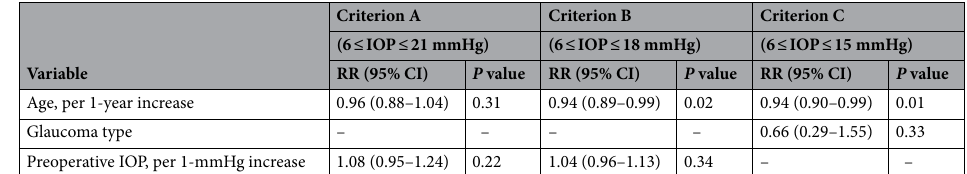
Table 6. Multivariate analysis to reveal the factors associated with the surgical outcomes of BGI for OAG using the Cox proportional hazards model. BGI Baerveldt glaucoma implant, OAG open-angle glaucoma, IOP intraocular pressure, RR relative risk, CI confidence